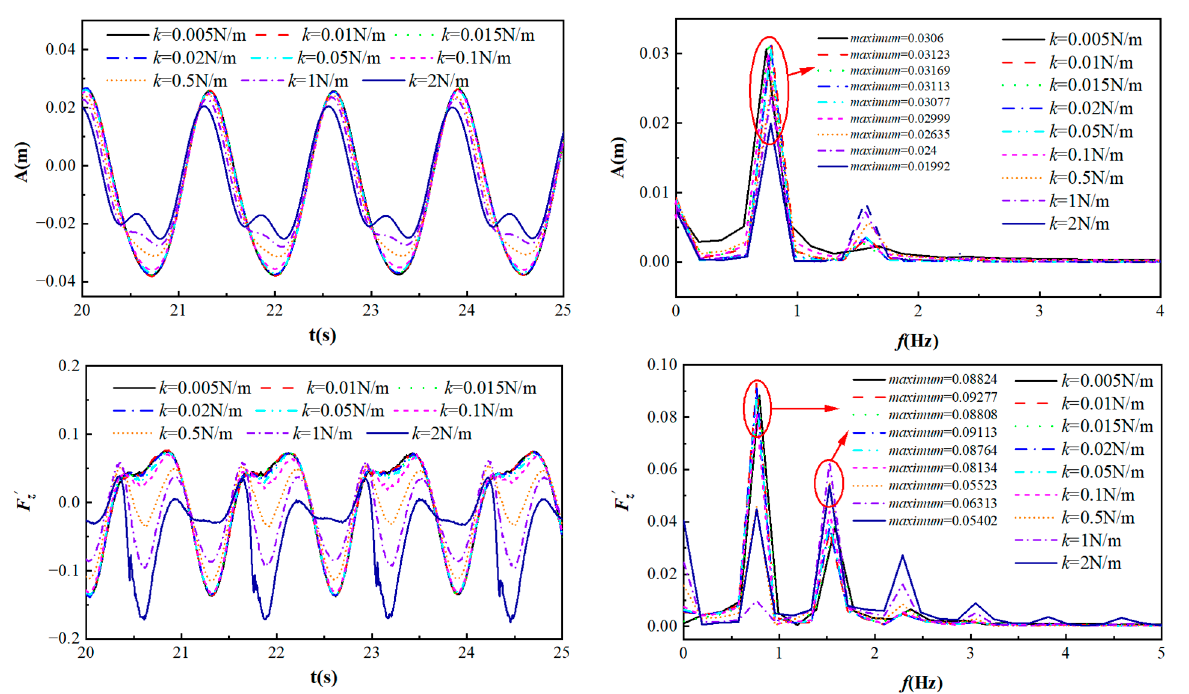
Figure 14. Time histories and power spectrum of wave–current force on cylinder at different k.